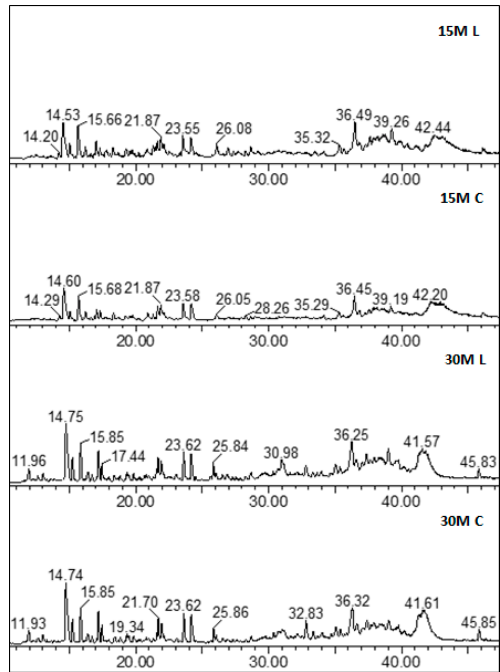
Figure 3. Examples of full-scan chromatograms .